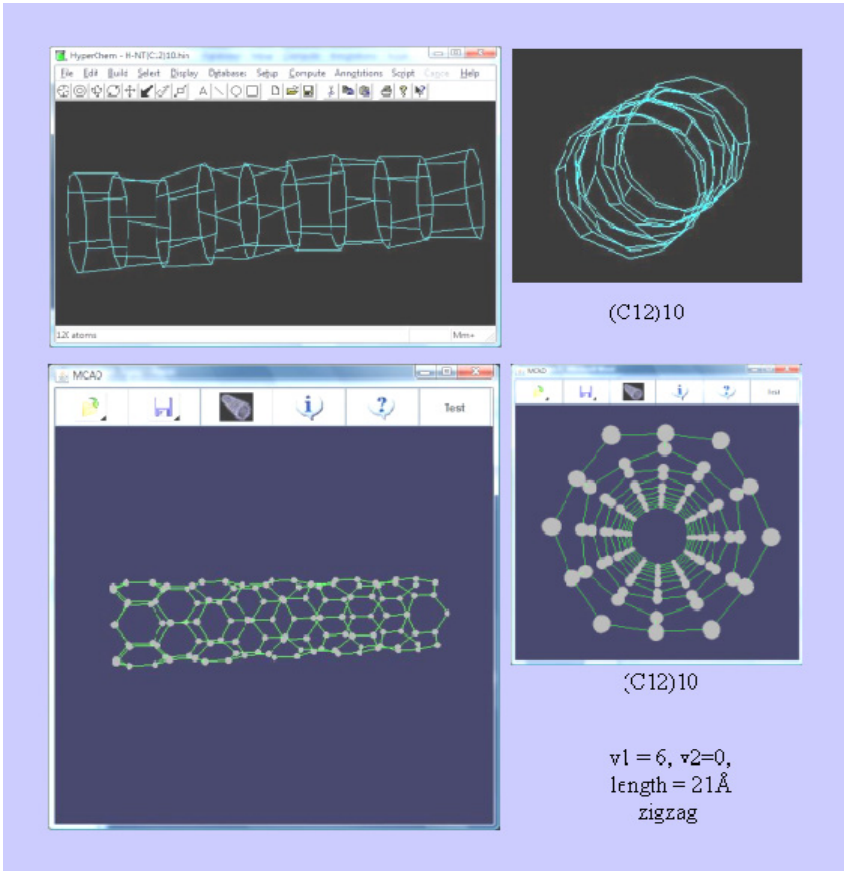
Figure 10. Outputs of (C12)10 nanotube of Table